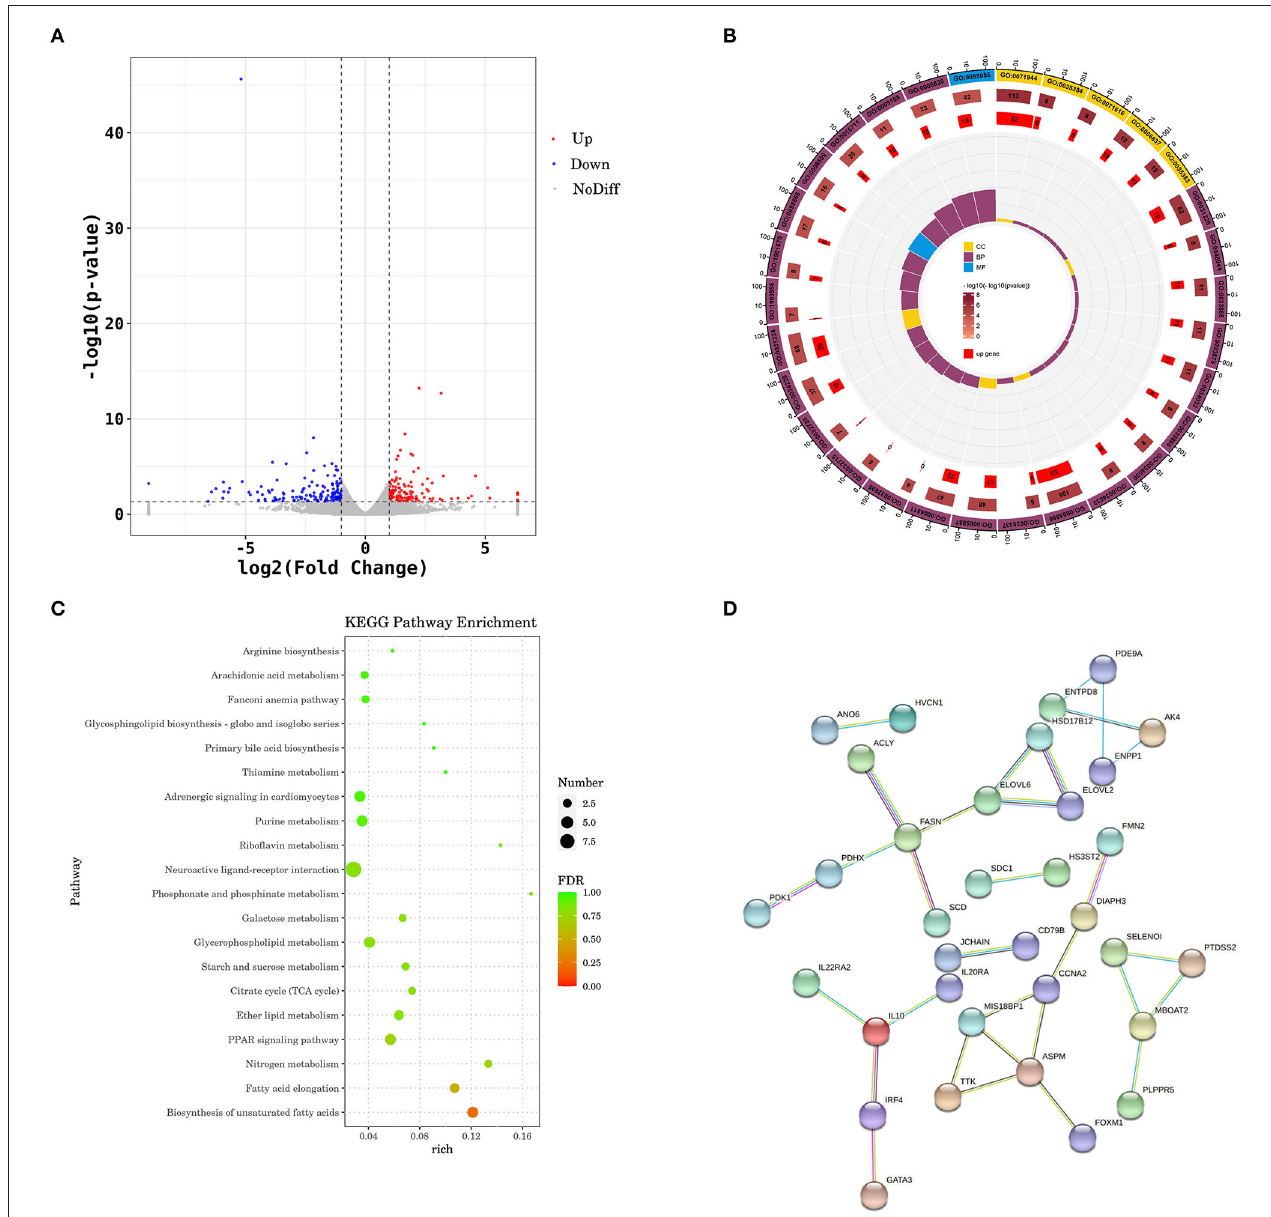
FIGURE 3 | Transcriptomics analysis of liver on PFF treatment. (A) Volcano plot for expression comparisons between PFF and control ducks in liver samples. Red points indicate the significantly differentially upexpressed genes [false discovery rate (FDR) < 0.05], and blue points indicate the significantly differentially downexpressed genes (FDR < 0.05), while gray points indicate the genes with no significant differences. (B) GO enrichment circle diagram. (C) KEGG pathway. (D) The subnetwork of the PPI